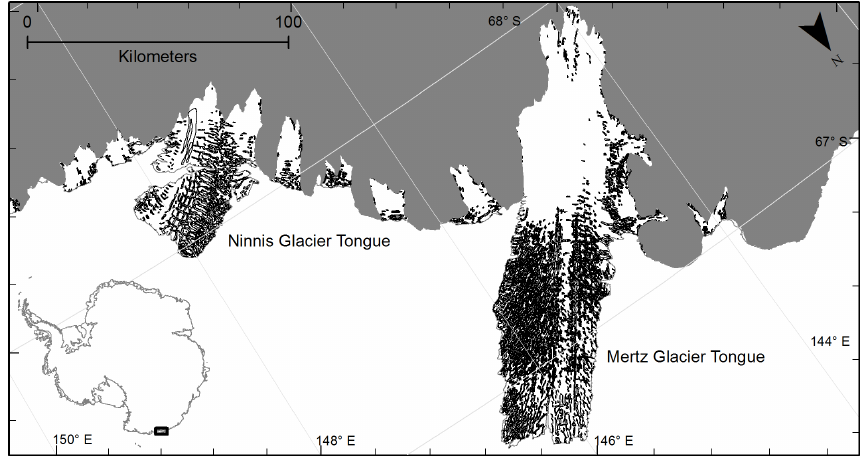
Map of detected surface structures on the Mertz and Ninnis Glacier Tongues. The grey lines represent the coastline taken from RAMP AMM-1 (http://bprc.osu.edu/rsl/radarsat/data/) and the grounding line taken from Haran et al . [23]. The grounded portion of the ice sheet in presented as grey